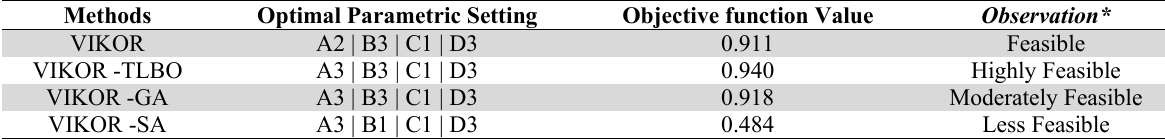
Comparative evaluation of evolutionary algorithms